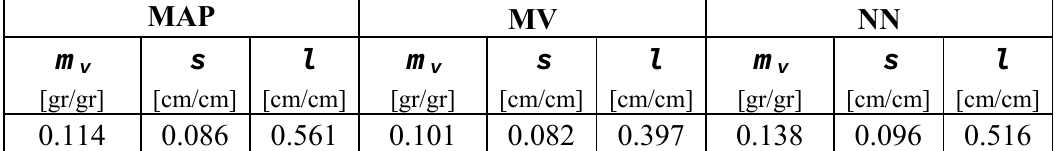
Table 2 . Same as Table 1 , but assuming a statistical correlation between s and l